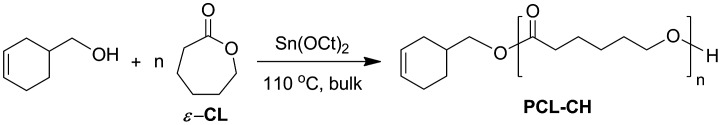
Synthesis of PCL-CH via ROP.